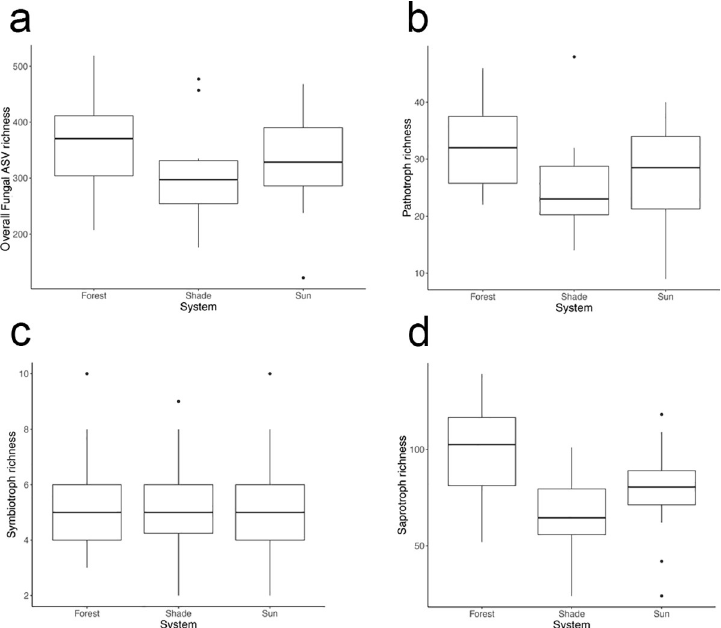
Fig 6. Boxplots of overall fungal richness and trophic mode richness across sun, shade and forest systems. Similar numbers of a. fungal taxa, b. pathotrophs and c. symbiotrophs were found in soil across systems. d. Saprotrophs richness was higher in the forest soil than in the traditional shade coffee system, and almost higher than the sun- intensive coffee system.